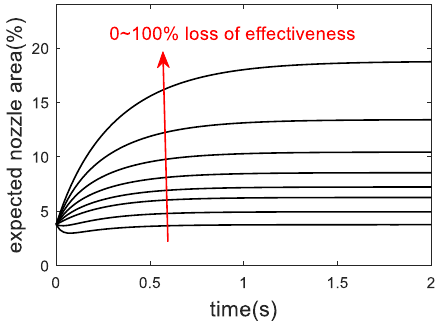
Figure 7. Expected nozzle throat area of A 8 in SMC design.